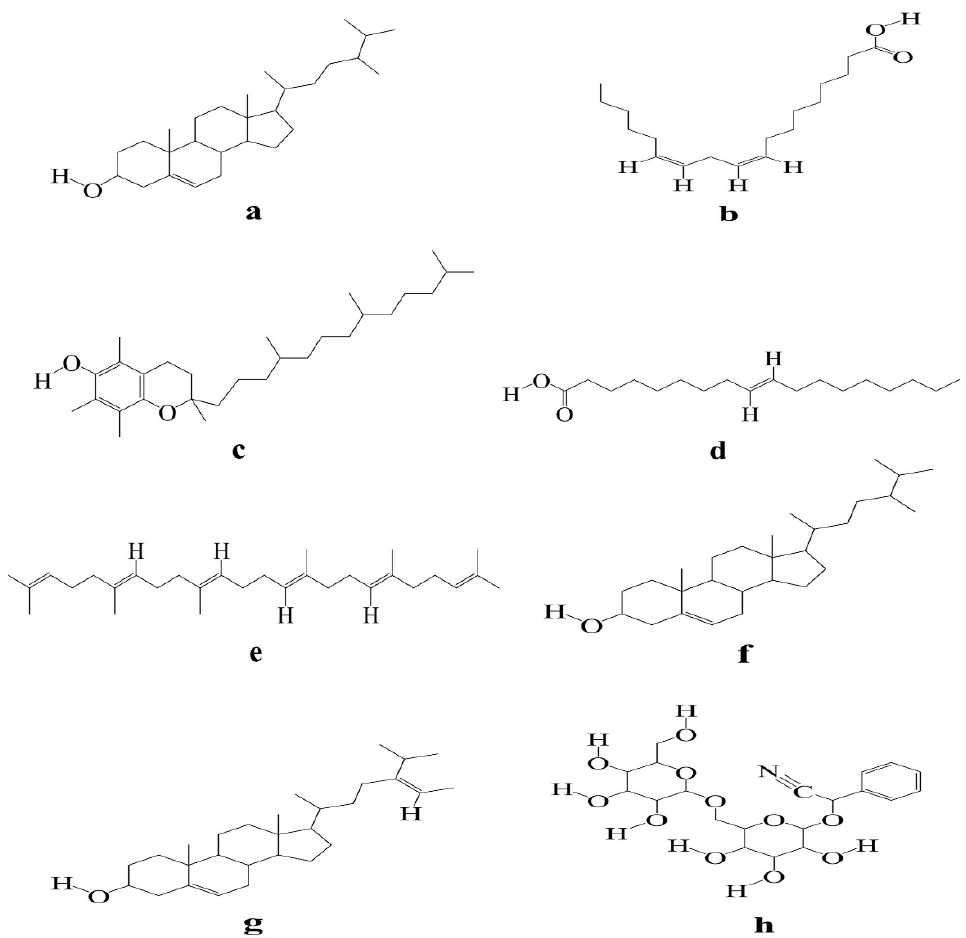
Figure 10. Structure diagram of eight chemical components (Note: ( a ) β -sitosterol, ( b ) linoleic acid,